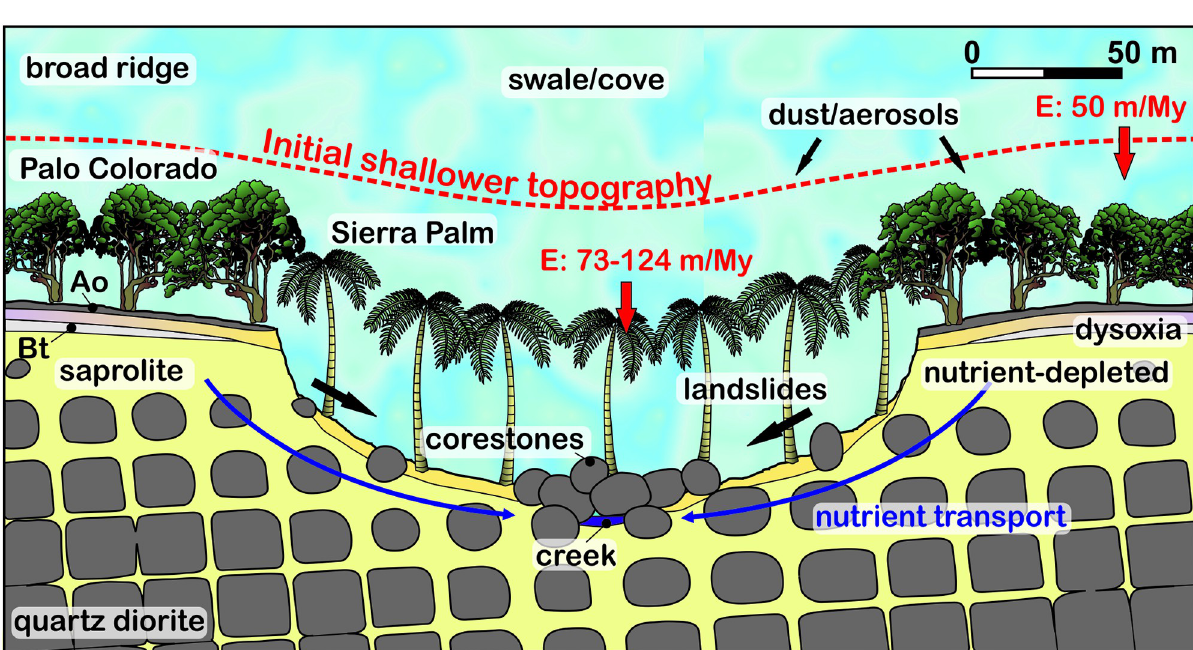
Fig 6. Conceptual model of relief development due to faster erosion in the coves. E: denudation rate from terrestrial 10 Be analysis. Ao: soil litter, Bt: clay accumulation horizon (see S2 Fig 2 in S2 File for corresponding field photographs).